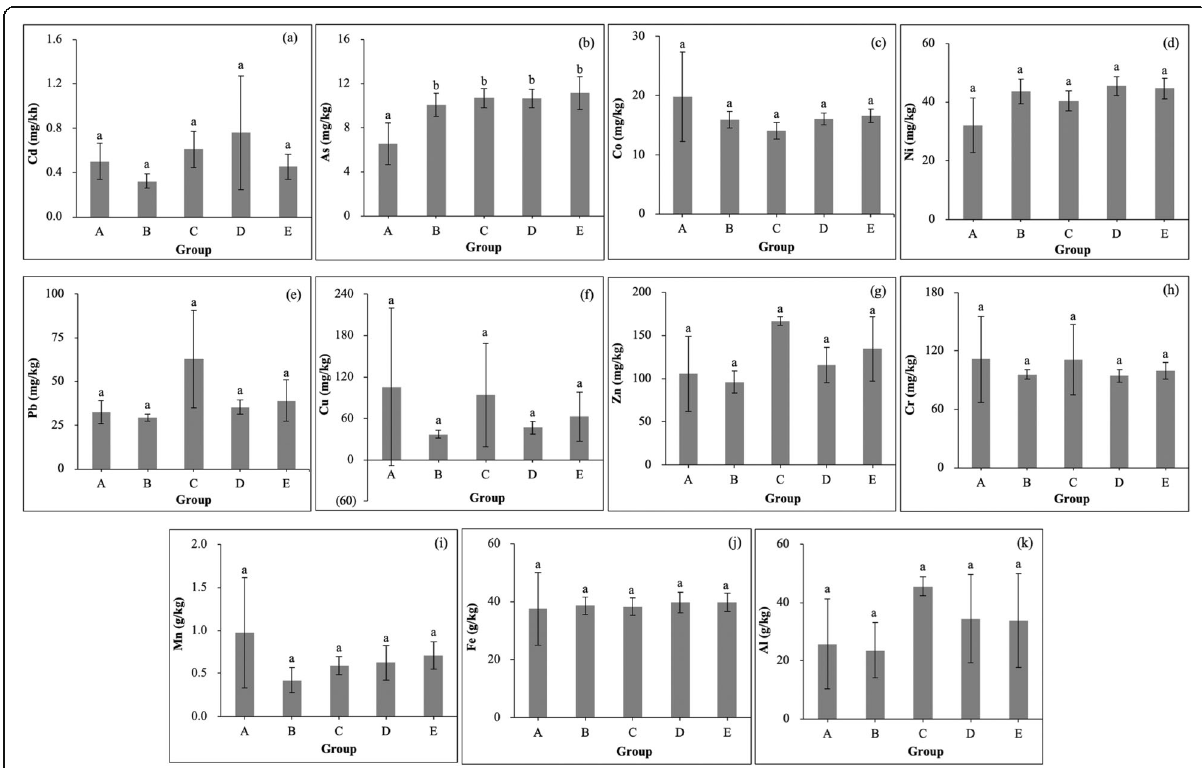
Fig. 3 Concentrations (mean ± SD) of a Cd, b As, c Co, d Ni, e Pb, f Cu, g Zn, h Cr, i Mn, j Fe, and k Al in sediment samples of lakes along a rural to urban gradient in central China. Note: different letters above bars indicate significant group difference ( P < 0.05)